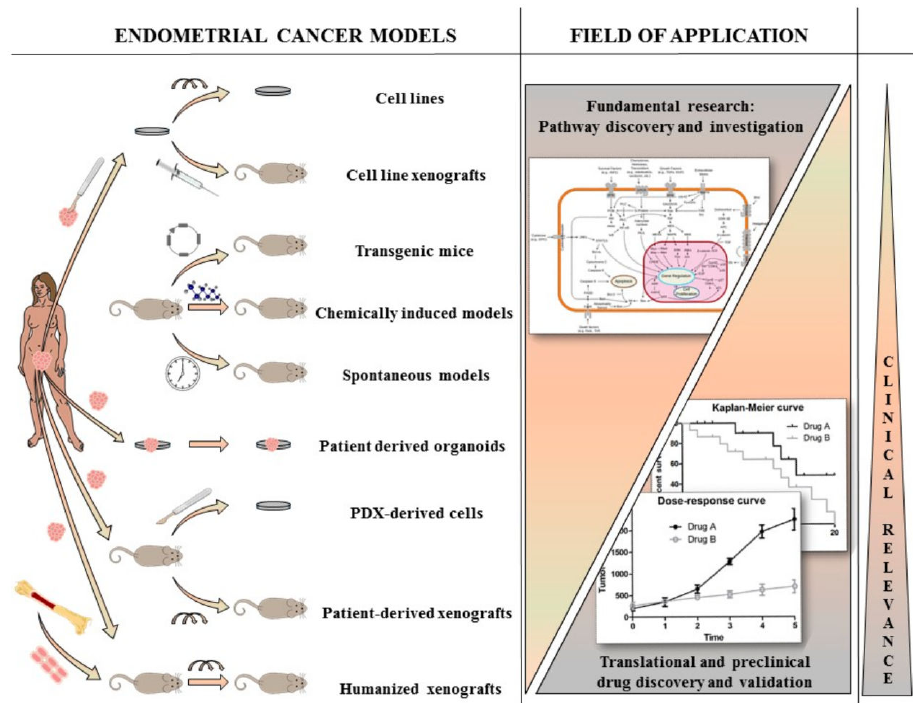
Figure 1. Presentation of the different available preclinical models present for endometrial cancer (EC) research. Cell lines and their derived xenografts are models for basic EC research however lack clinical relevance. Better, in vivo models are transgenic, chemically induced and spontaneous models, however they lack patient-derived properties. Patient-derived models (organoids, xenografts and humanized mice) have the highest clinical relevance and are useful for translational and preclinical drug discovery and validation, however they are less likely to be used for fundamental